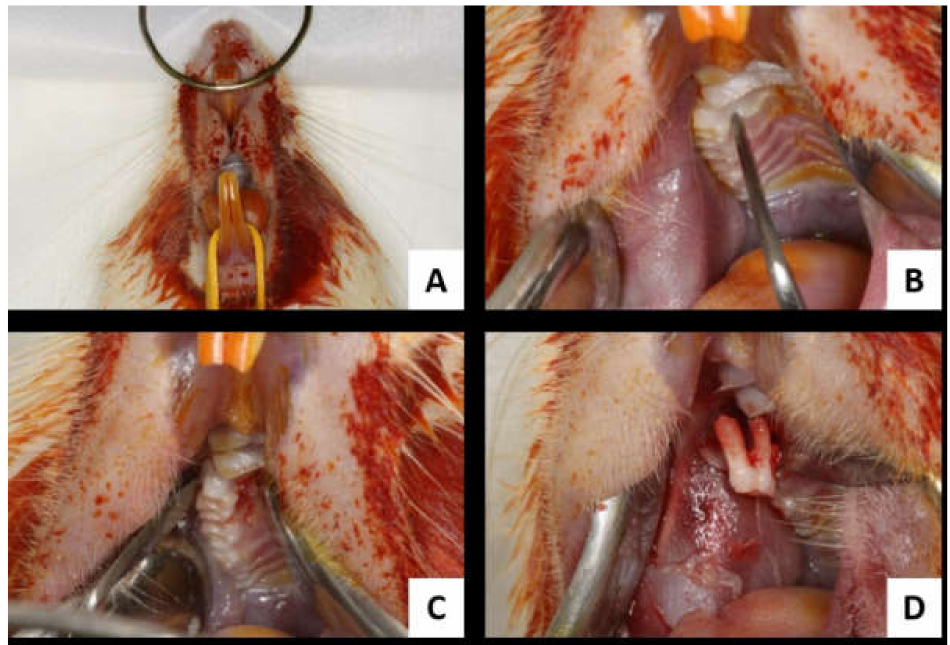
Figure 2. Tooth extraction. ( A ): operative site antisepsis; ( B ): syndesmotomy; ( C ): upper first molar dislocation; ( D ): first upper first molar